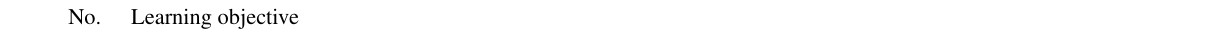
Figure 2. (a) Map of exposed Proterozoic rocks in the southwestern United States with major provinces and shear zones (modified after Karlstrom and Williams, 2006). FM–LM: Farwell Mountain–Lester Mountain zone. (b) Simplified geological map of Proterozoic exposures in the Front Range (modified after Tweto, 1979). Colorado Mineral Belt boundaries in both (a) and (b) approximated from Tweto and Sims (1963), Chapin (2012), and Caine et al. (2010). Table 1. Learning